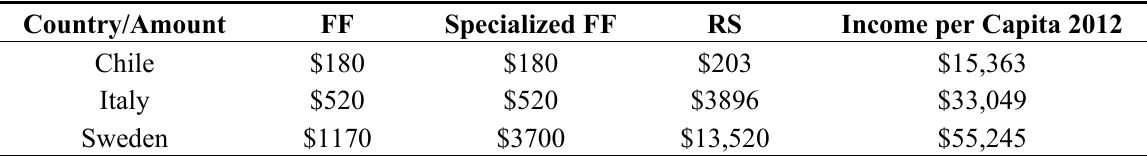
Table 1. Comparative table showing monthly subsidies in different countries based on per capita income (in US